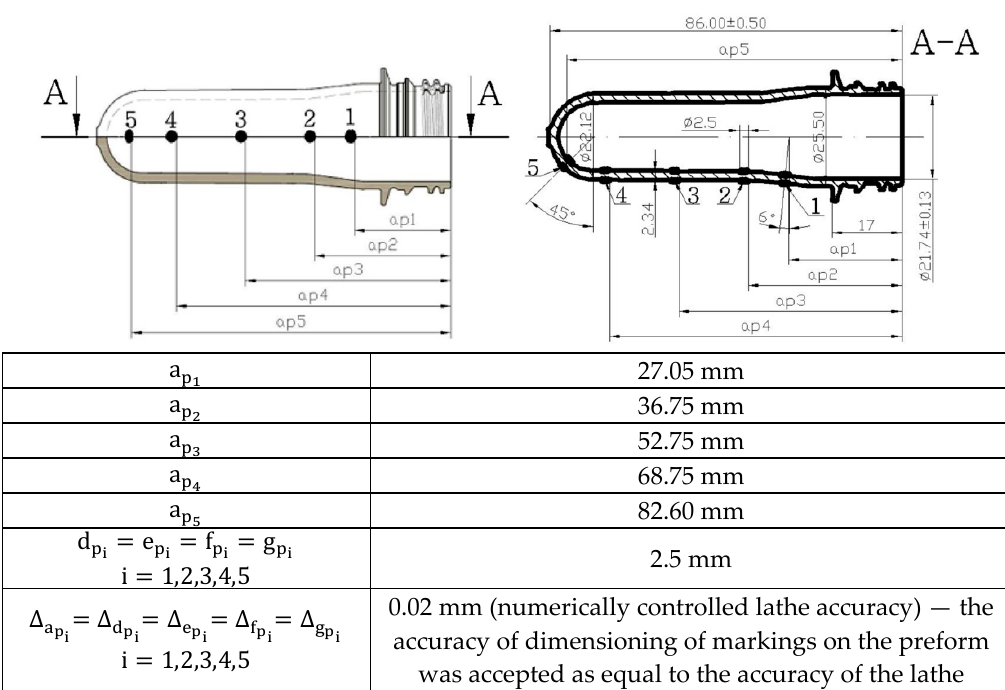
Figure 3. The dimensions of the preform used in the tests, as well as the location and dimensions marking applied to the outer and inner walls of the preform, used to define the coefficients of the bottle blow kinetics. Polymers 2020 , 12 , 1749